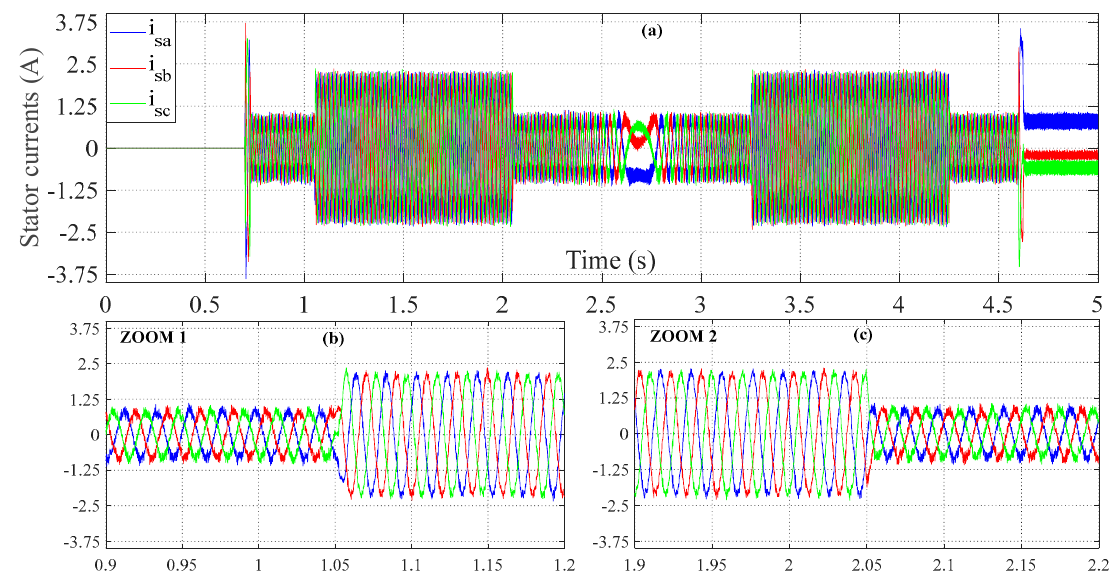
Figure 12. Stator currents ( a – c ) of the GA–DTC.